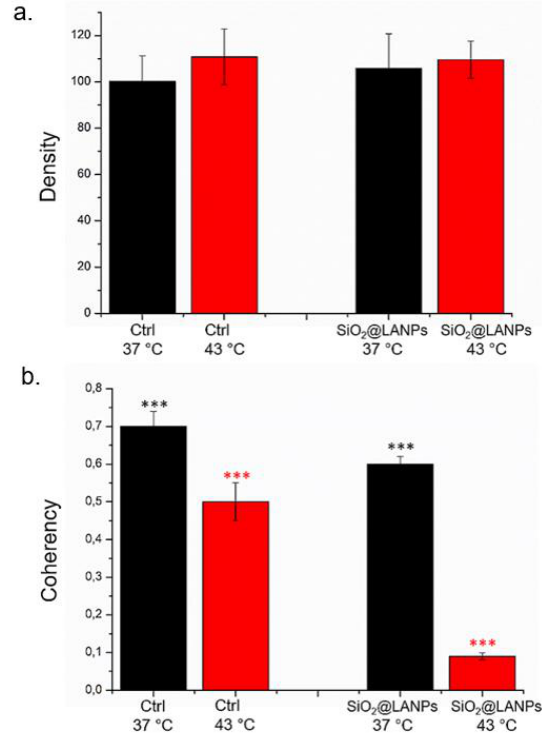
Figure 10. Integrated density ( a ) and coherency ( b ) for MCF-7 with 40 µ g / mL of SiO 2 @LA NPs after 48h. The integrated density and coherency values were expressed as a mean value and relative SD, calculated from confocal acquisitions by ImageJ (calculation on 15 cells). The mean values and their standard deviations were reported in the histograms. Results were statistically significant for p < 0.05 (0.005***).